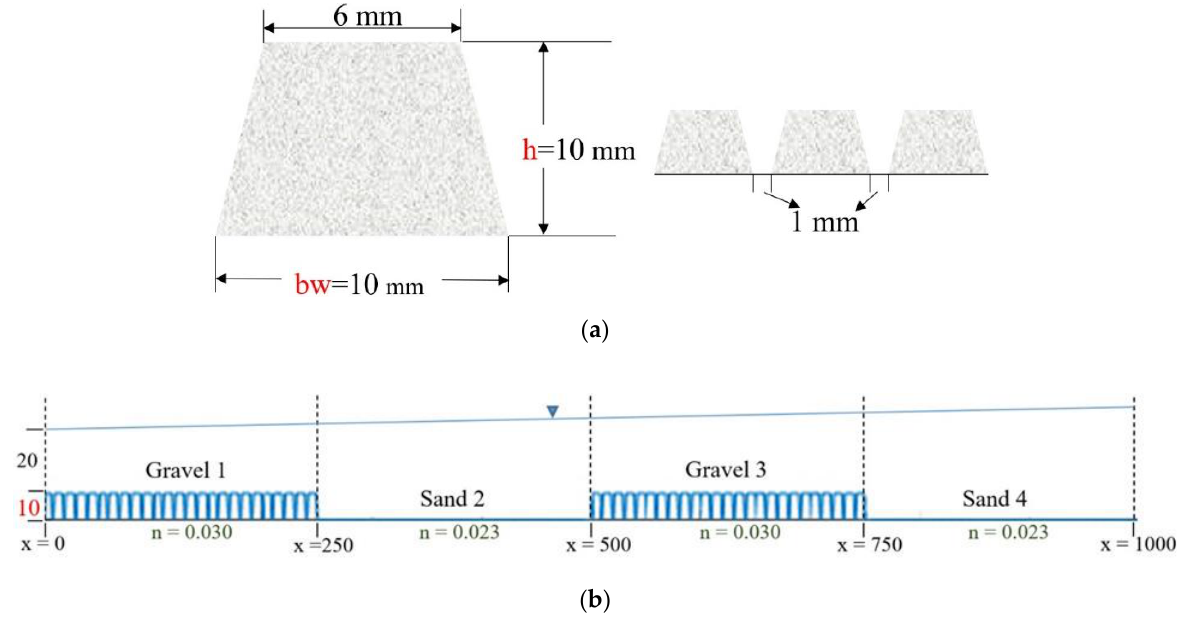
Figure 5. ( a ) Sketch of a single trapezoidal gravel piece with the dimension of 10 mm × 10 mm used as base case. ( b ) Sketch of consecutive gravel pieces with the dimension of a gap among them. Streambed with 10 × 10 trapezoidal gravel pieces is used as a base case. Four zones of gravel and sand with Manning’s roughness coefficient, n, can be seen.